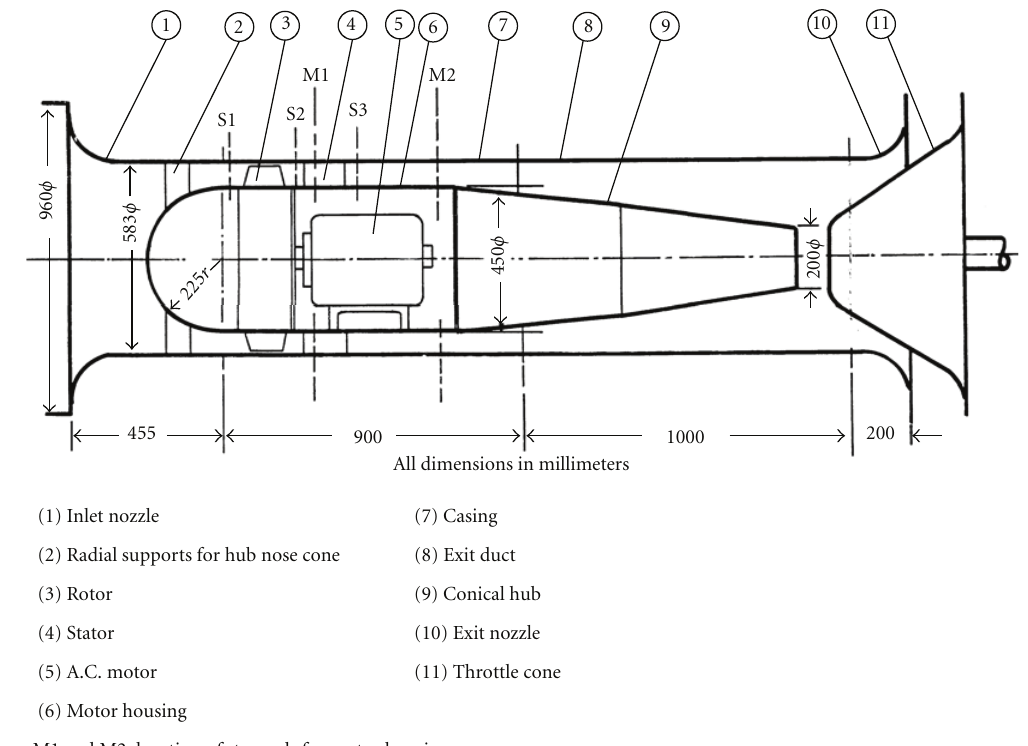
Figure 1: Schematic of the low-aspect-ratio axial-flow fan